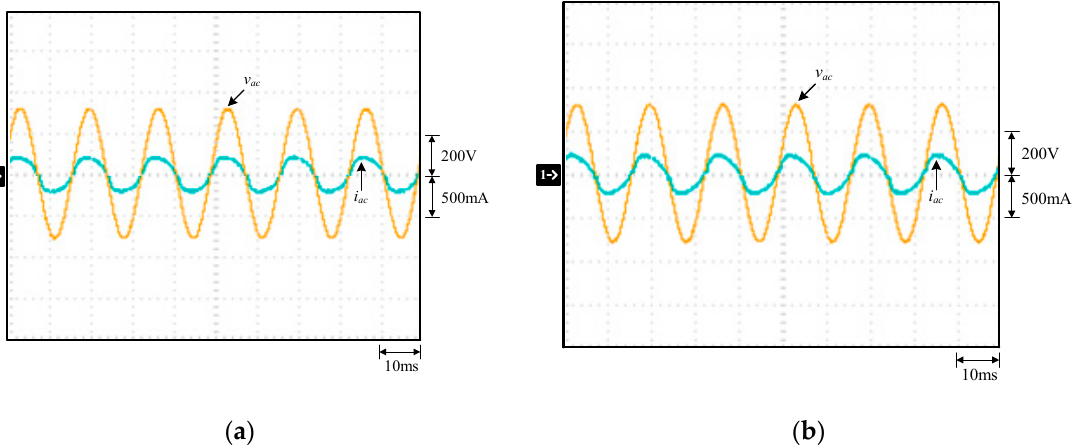
Figure 8. Waveforms under 110 V input voltage and 100% output load: ( a ) without; ( b ) with the proposed low-frequency current ripple improved: (1) Δ v f ; (2) Δ i o .